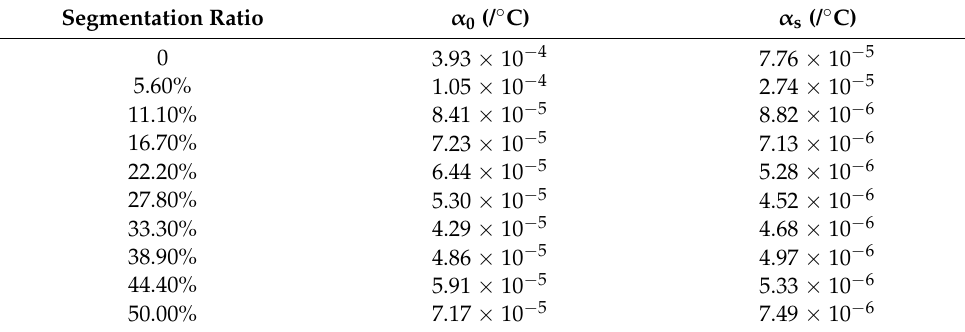
Table 8. Drift parameters of sensors at different segmentation ratios.